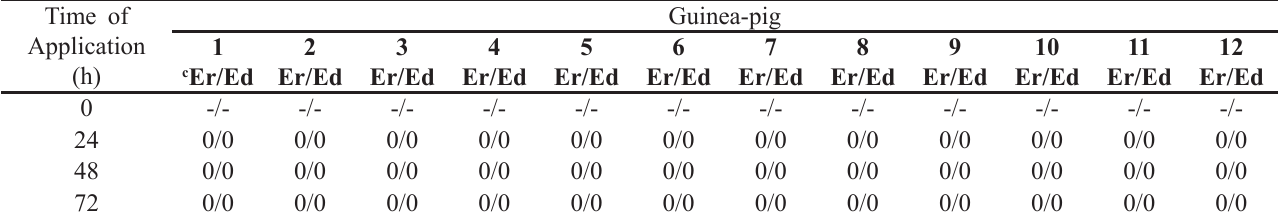
TABLE VI - Edema (Ed) and Erythema (Er) measured from tests conducted after application of a liquid soap a . Twelve guinea-pigs were used (1 st to 6 th guinea-pigs with normal skin and 7 th to 12 th guinea-pigs with abraded skin) b, c Time of